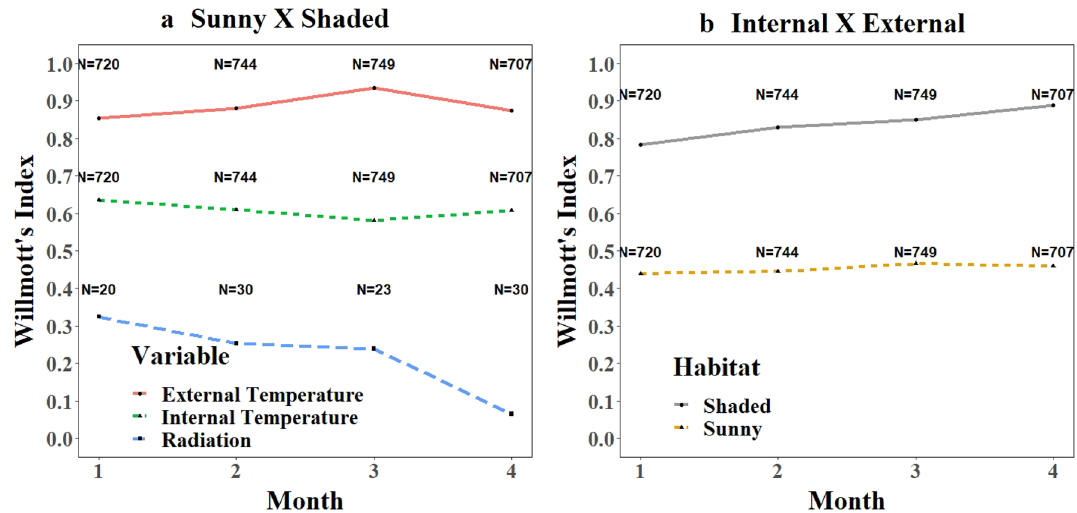
Figure 1. Temperature and irradiance over the first 4 months of Atta sexdens (Hymenoptera: Formicidae) nests in sunny and shaded environments. Willmott similarity index between irradiance and inside and outside temperatures ( a ) and between outside and inside temperatures ( b ) in sunny and shaded environments. (N = sample